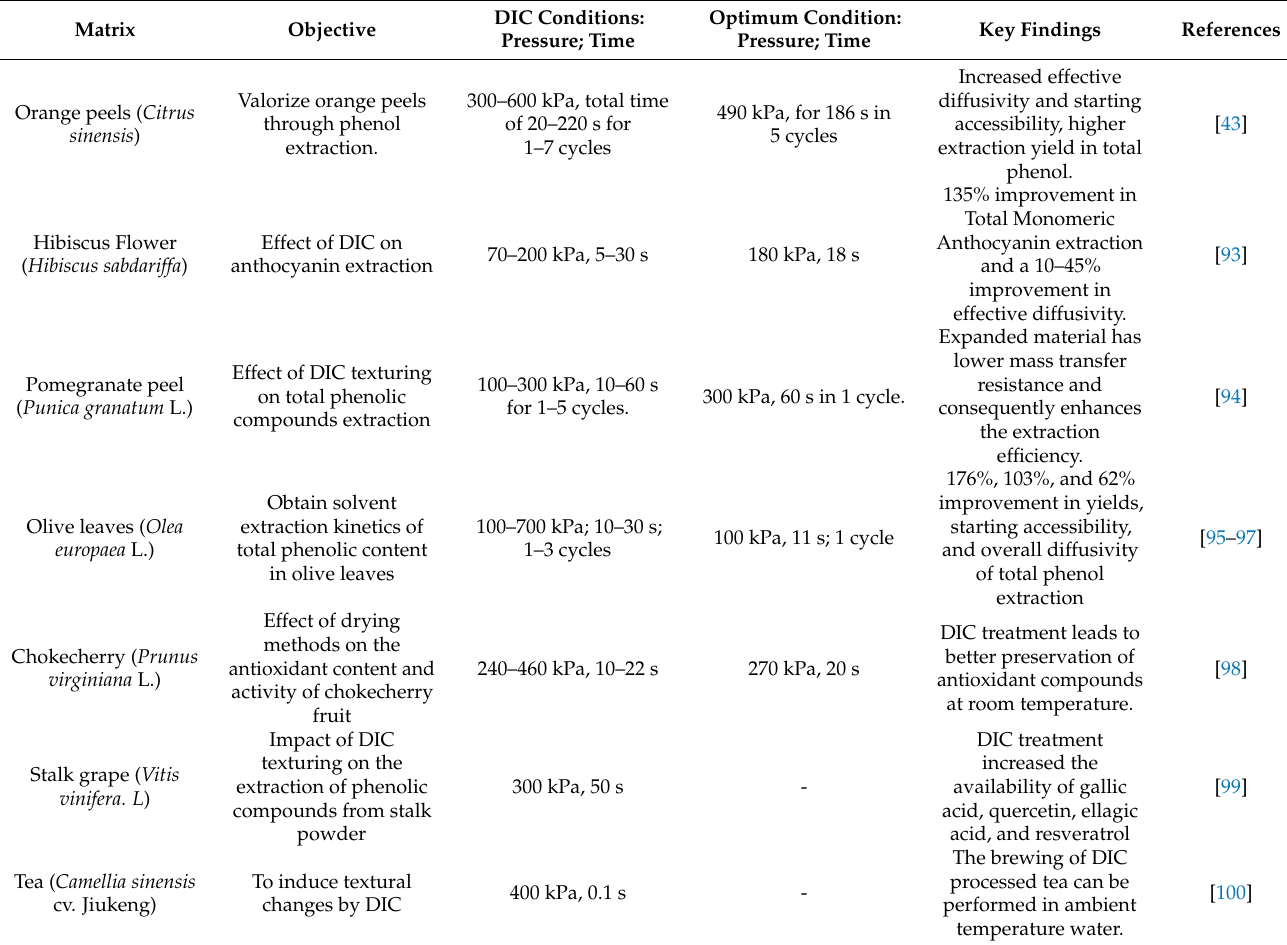
Table 7. Antioxidant extraction as modified by DIC